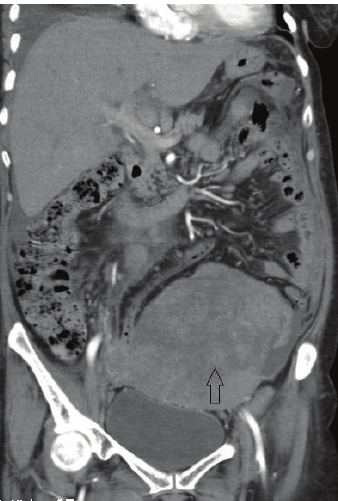
Figure 3: CT scan revealed a large mass of the left ovary with pelvic tissue